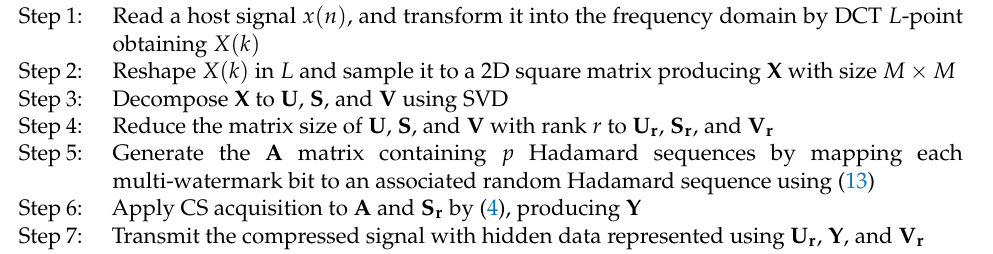
Table 1. Embedding process.